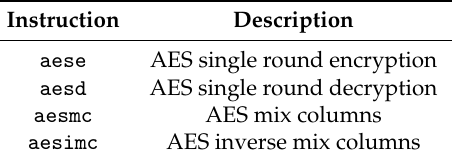
Table 1. AES instructions on